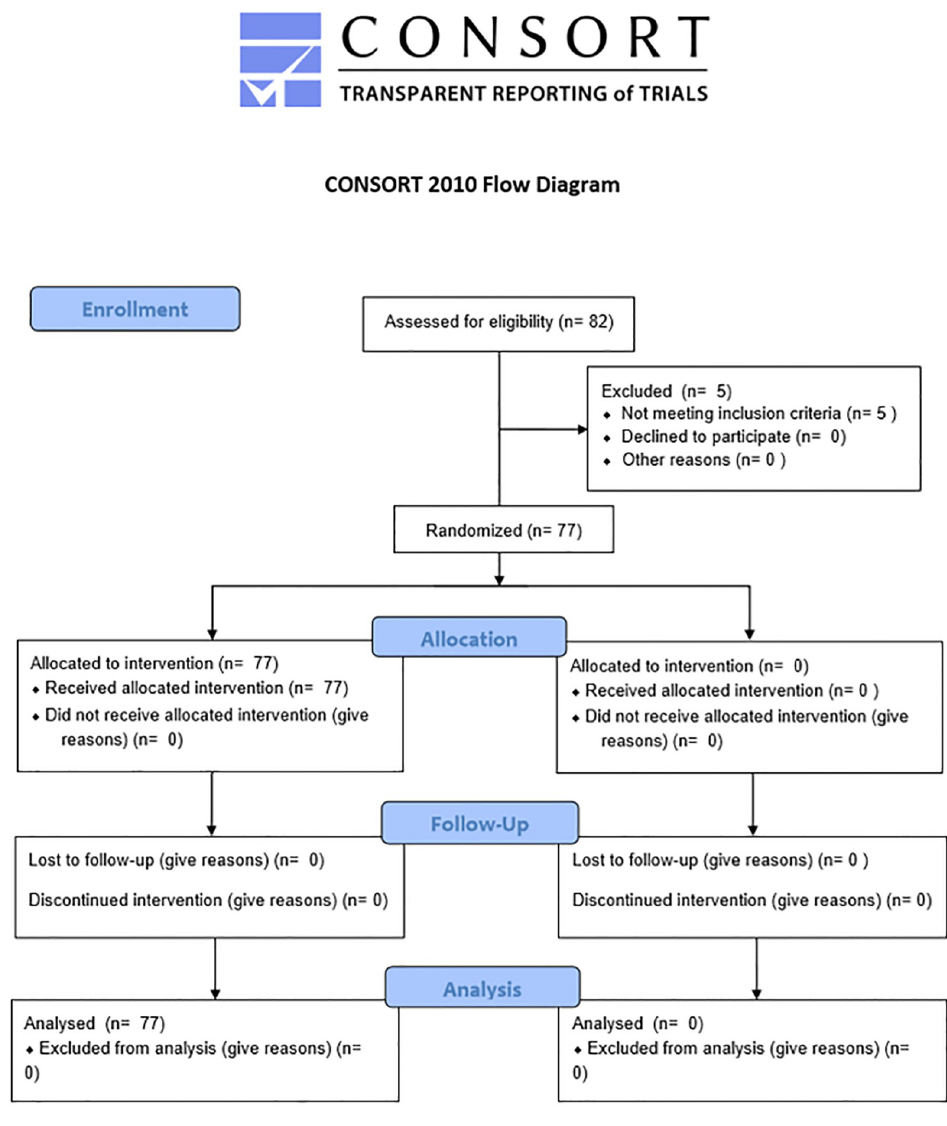
Fig 1. The CONSORT flow